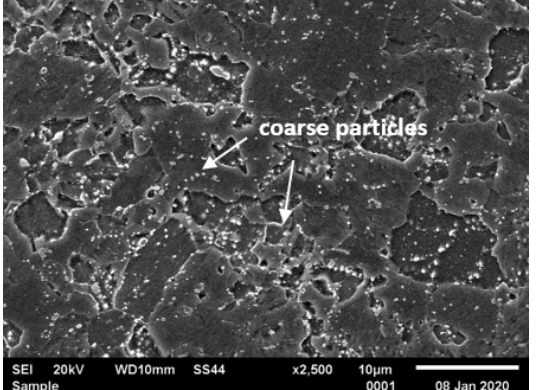
Figure 8. Microstructure of fine-grained heat-affected zone (FGHAZ)/intercritical heat-affected zone (ICHAZ) in T115 steel joint—joint No. 1.